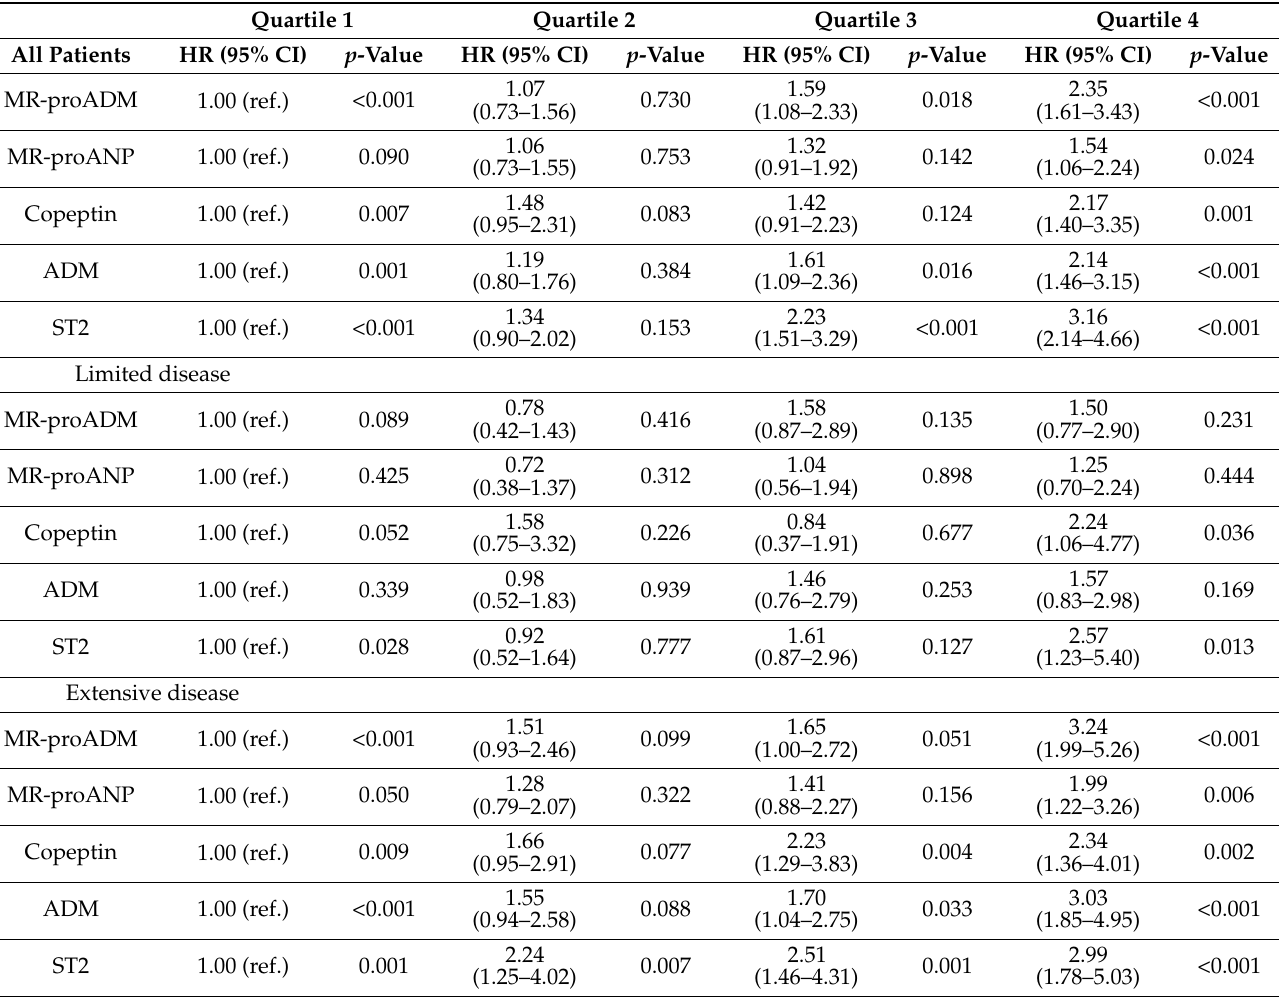
Table 2. Unadjusted effects of circulating biomarker levels on overall survival for all patients and by disease stage.